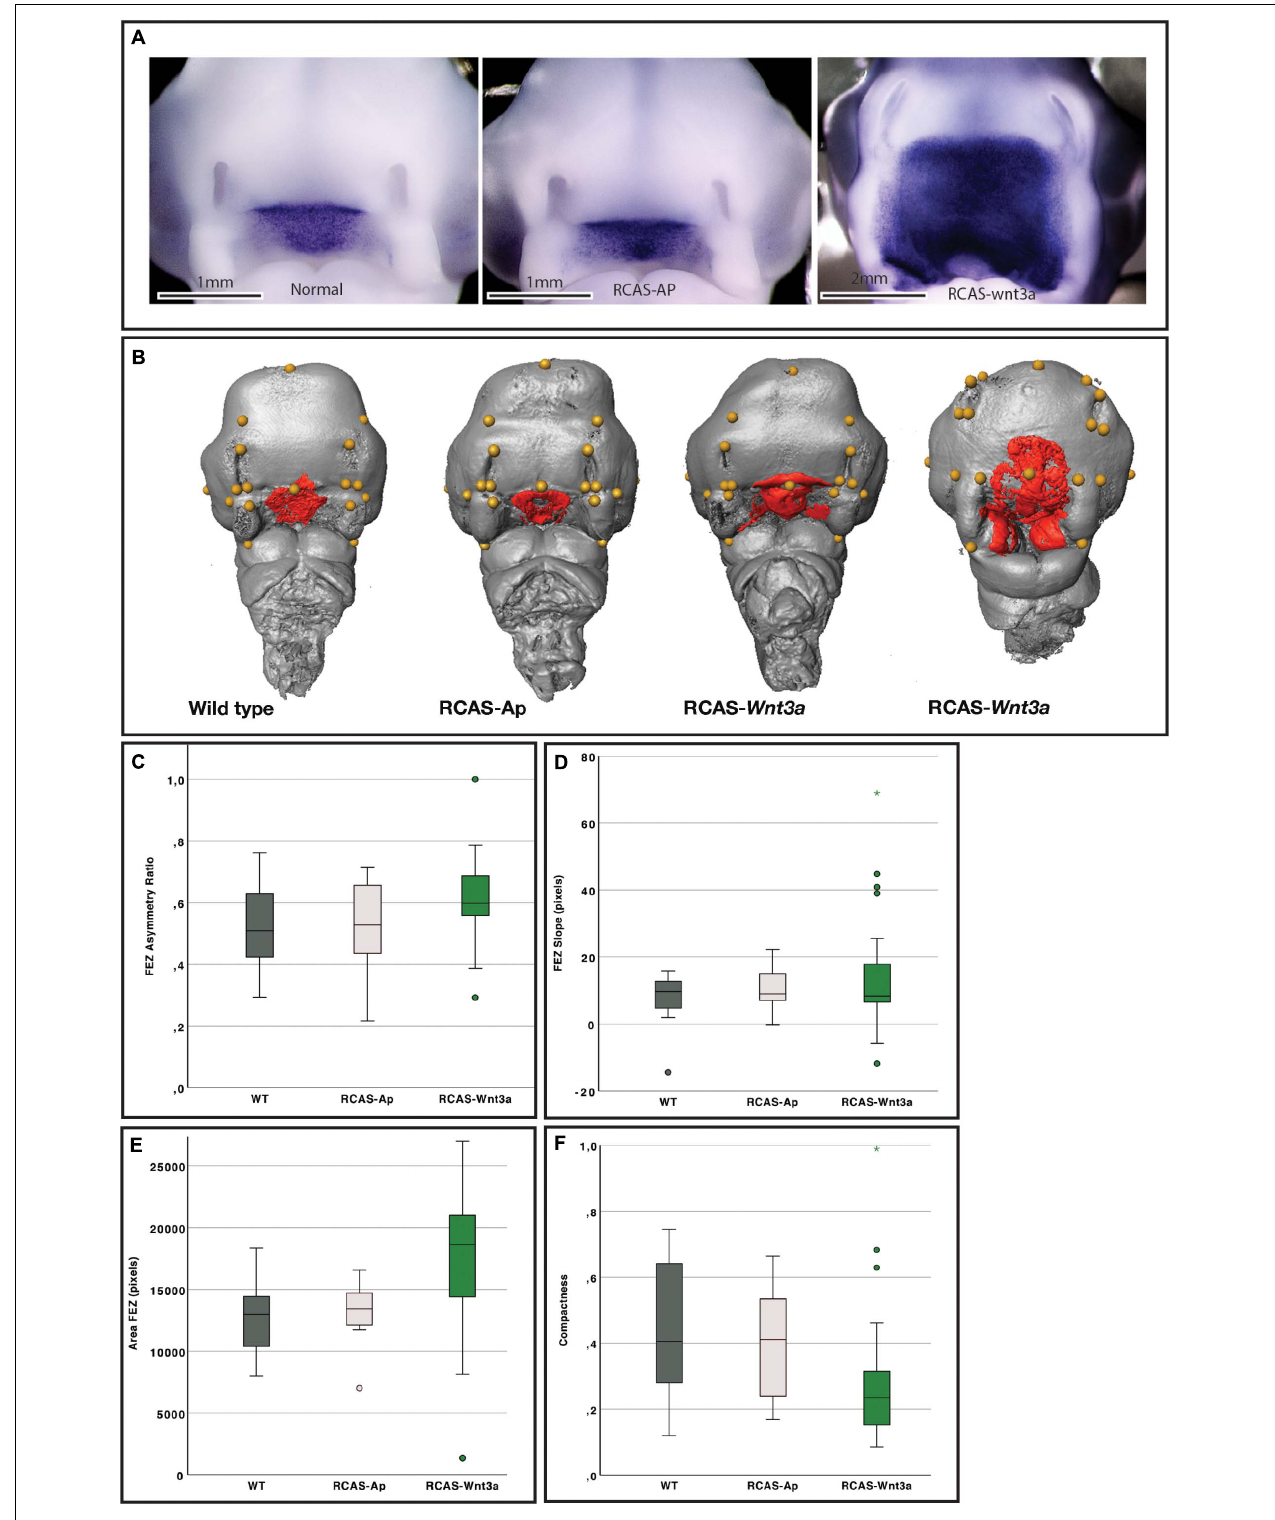
FIGURE 1 | Impact of Wnt3a on head and FEZ shape at stage HH22. (A) In situ hybridization for SHH . (B) Examples of head (gray) with landmarks (yellow), and FEZ (red) shape identified by Shh expression using in situ hybridization. From left to right: wild-type (WT), RCAS-Ap, RCAS- Wnt3a with mild phenotype, and RCAS- Wnt3a with severe phenotype. Boxplots of FEZ variables: (C) asymmetry ratio; (D) slope; (E) area; (F) compactness.